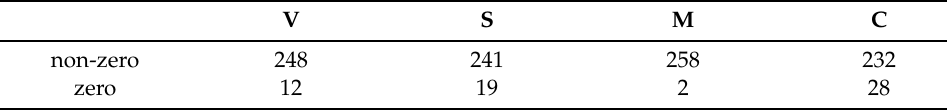
Table 6. Cases where no keystrokes were recorded, by